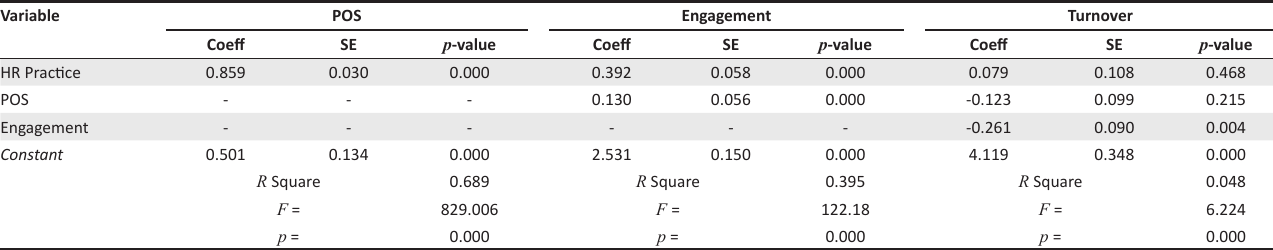
TABLE 8: Regression analysis. Variable